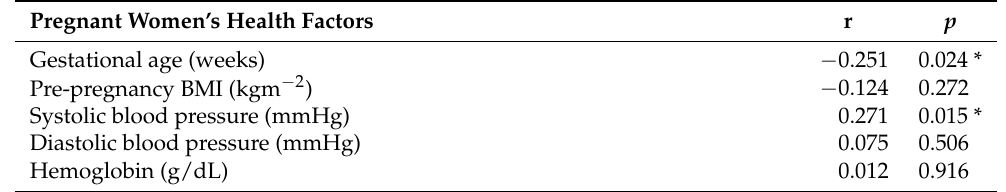
Table 4. Correlation coefficient (r) between BLLs and pregnant women’s health ( n = 80).